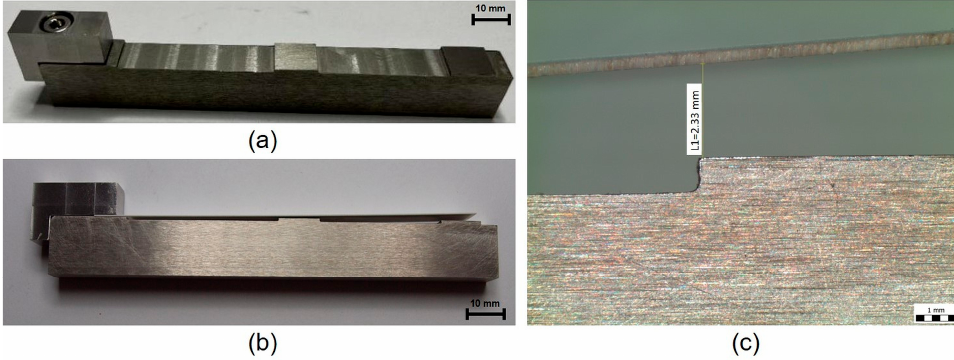
Figure 3. ( a ) Fixture for clamping of the test specimen; ( b ) fixture with clamped substrate (cantilever); ( c ) measurement of clamped substrate deflection by stereomicroscope.